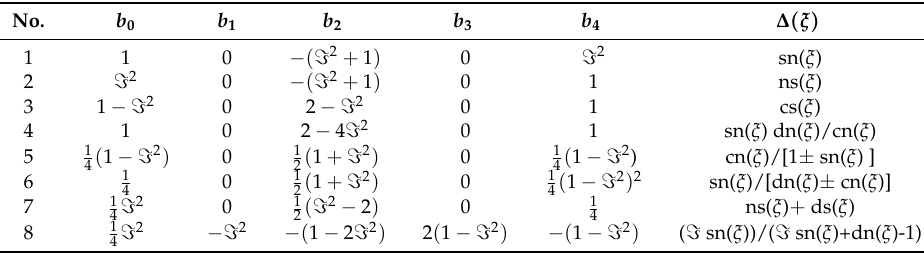
Table 1. JEFS with different types 0 < (cid:61) < 1.